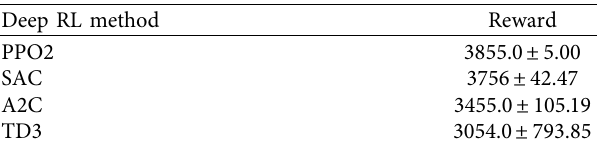
Table 3: Results obtained from various deep reinforcement learning models.